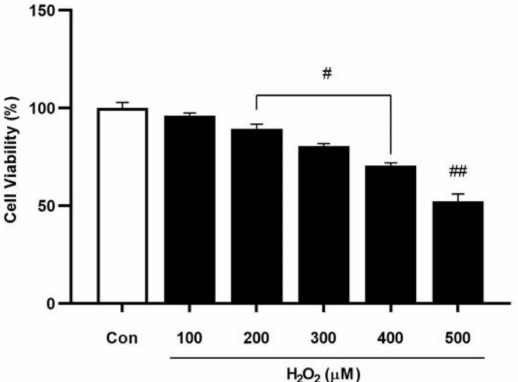
Figure 7. HaCaT cells were treated with H 2 O 2 (100–500 µ mol) for 24 h. Graphs exhibits mean ± SD values of four replications. The graph represents the mean ± SD values of four replications. # p < 0.05, ## p < 0.01 indicates significant differences from control group.